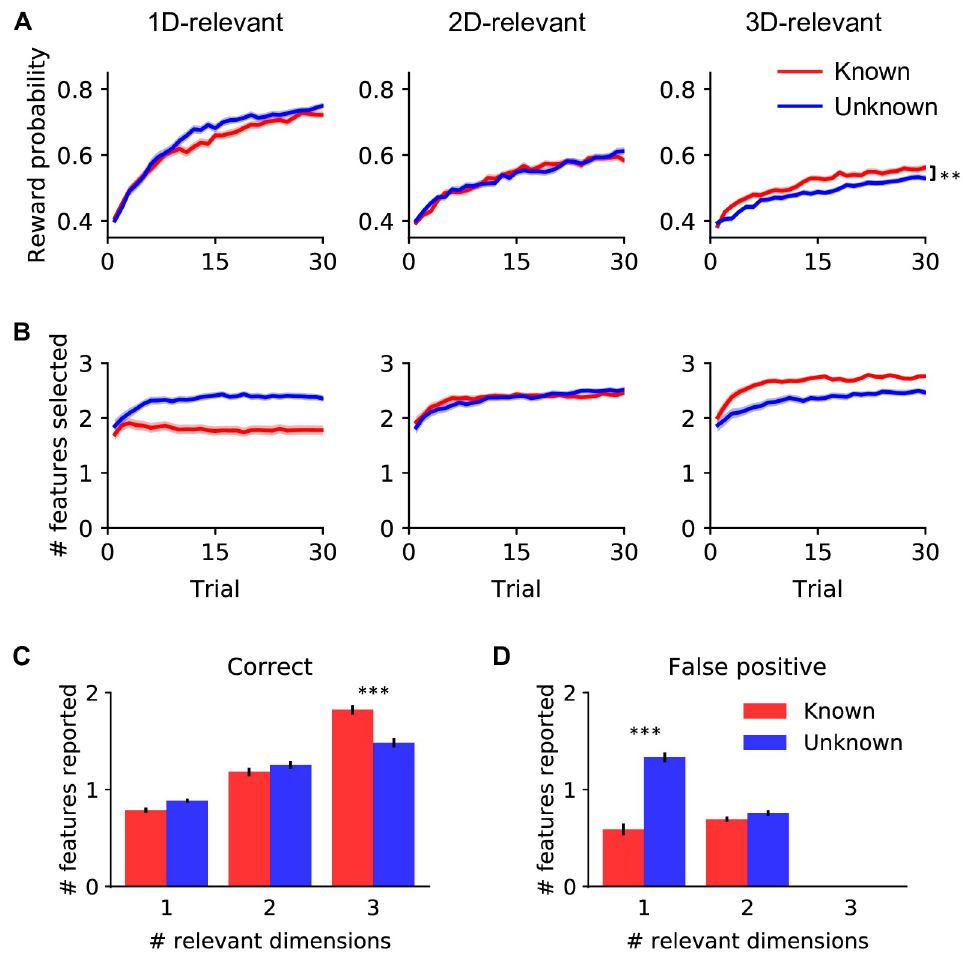
Fig 2. Participants’ behavior in the “build your own icon” task. (A, B): Performance and choices over the course of a game, by game type . (A) Participants’ average probability of reward (based on the number of rewarding features in their configured stimuli), over the course of 1D-, 2D- and 3D-relevant games (left, middle and right columns). Red and blue curves represent “known” and “unknown” conditions, respectively. For all game types, chance reward probability is 0.4 and 0.8 is the maximum reward probability. Shading (ribbons around the lines) represents ± 1 s.e.m. across participants. �� p < .01. For grouping of these learning curves by task complexity, see S1 Fig. (B) Same as in (A), but for the number of features selected. (C, D): Responses to post-game questions regarding the rewarding features in each game condition . (C) Average number of correctly-identified rewarding features; (D) Average number of false positive responses, i.e., falsely identifying an irrelevant dimension as relevant. ��� p < .001. Error bars represent ± 1 s.e.m. across